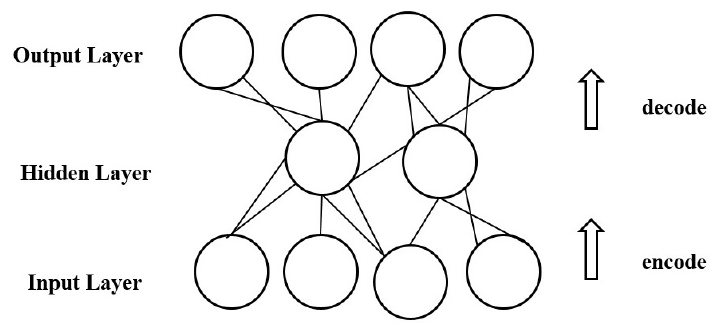
Figure 3. Autoencoder